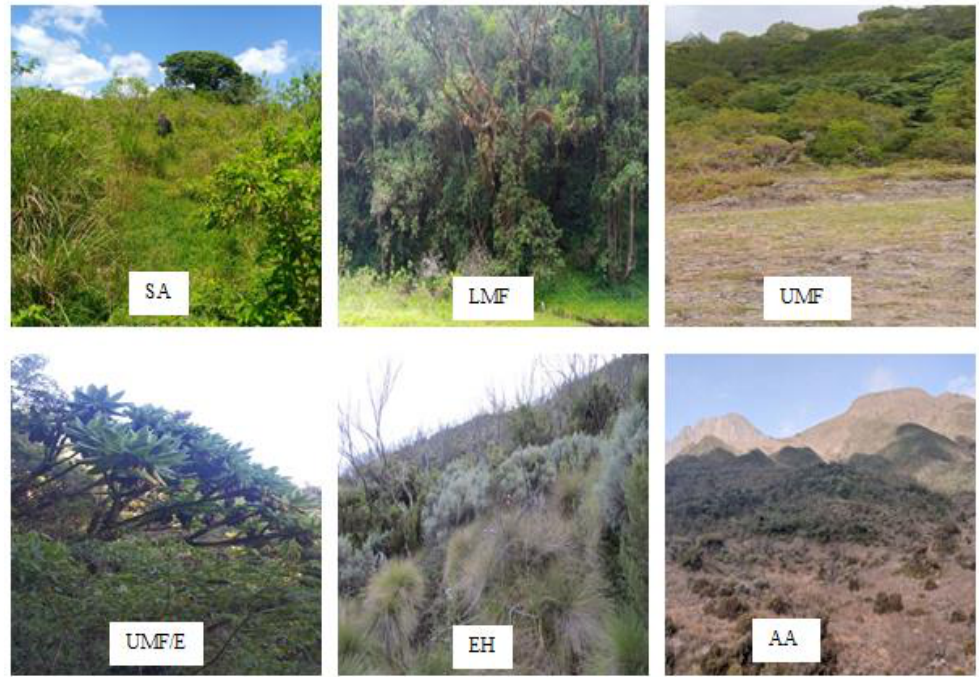
Figure 2. Photographs of representative habitats for each site sampled on Mount Meru, Tanzania. SA (savanna grassland), LMF (lower montane forest), UMF (upper montane forest), UMF/EH (upper montane forest/Ericaceous heathland), EH (ericaceous heathland), and AA (Afroalpine).